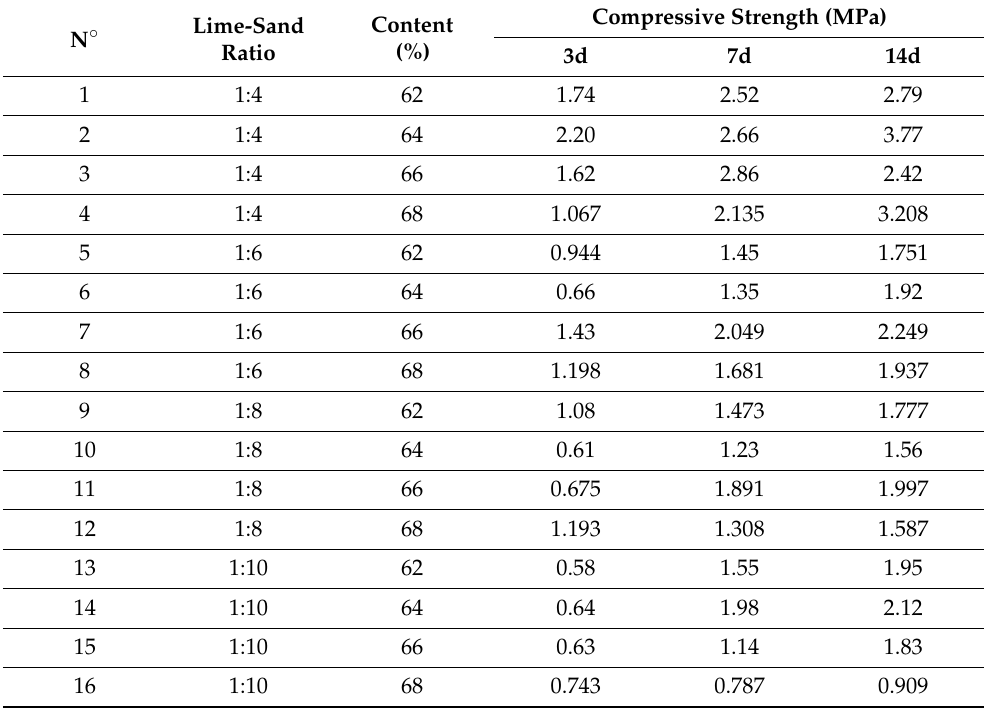
Table 2. Proportioning test results.